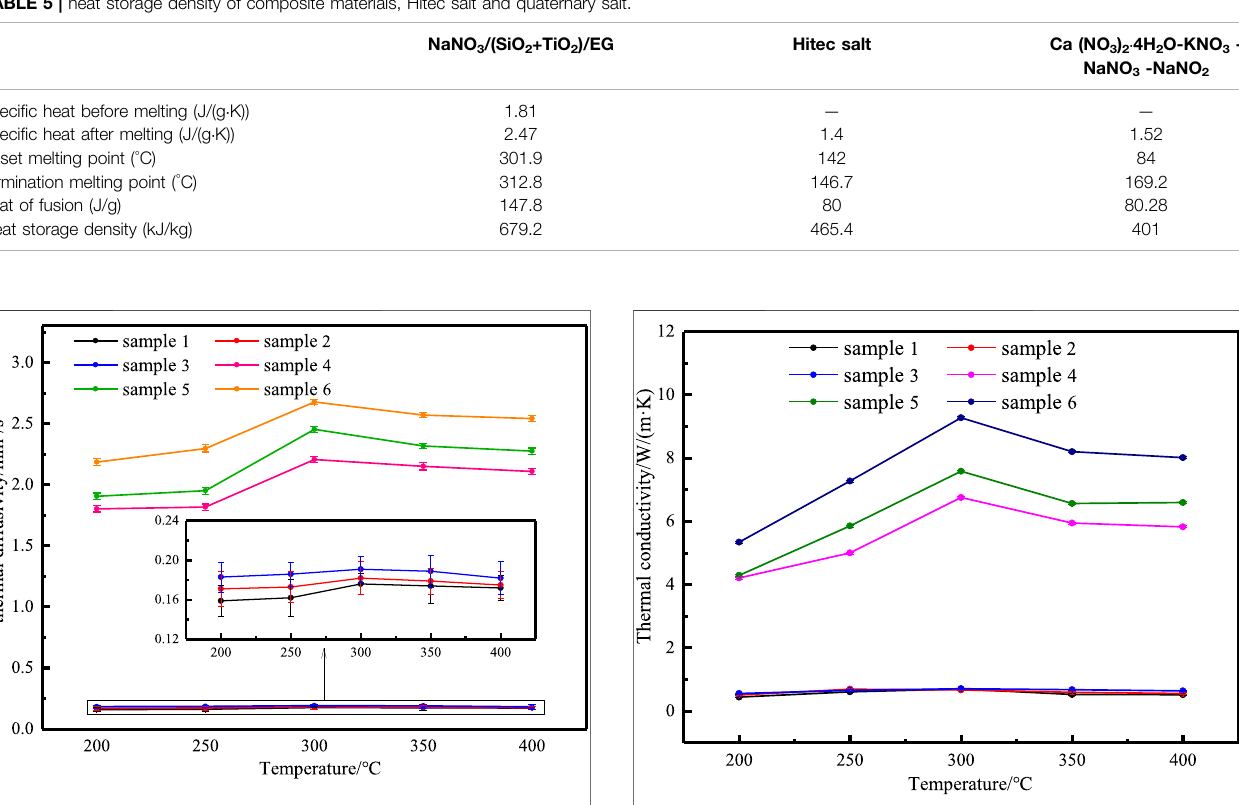
FIGURE 10 | Thermal diffusivity of different samples vary temperature.